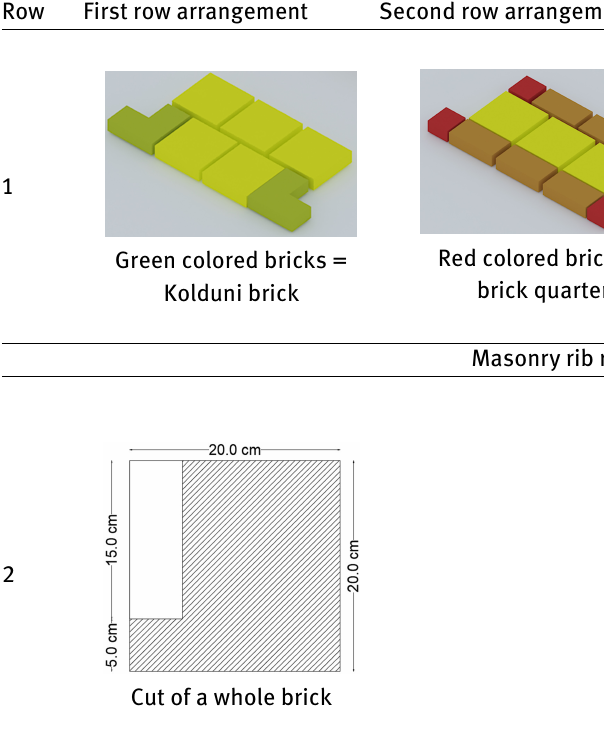
Table 2: Perspective and photos of some samples of masonry rib implementation with radial brick vault arrangement method